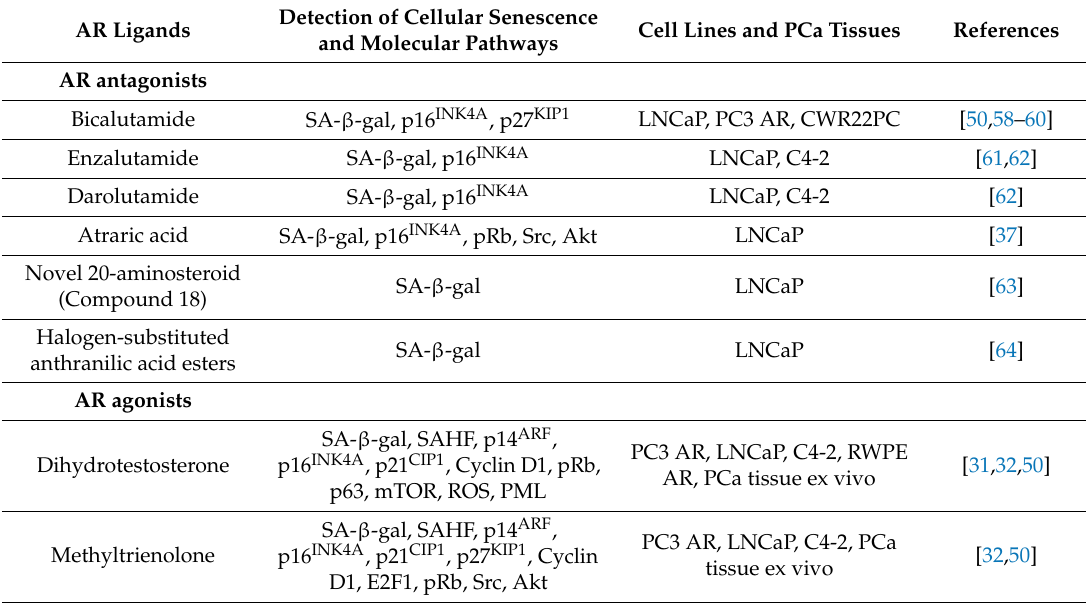
Table 1. List of AR ligands, which induce cellular